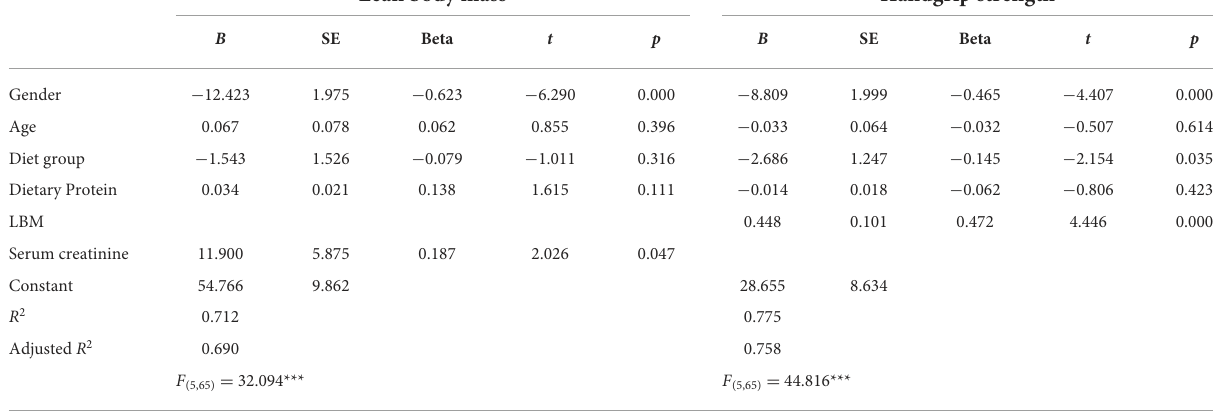
TABLE 3 Multiple regression results predicting lean body mass and handgrip strength. Lean body mass Handgrip strength